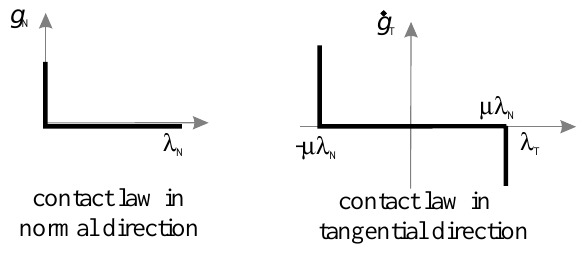
Fig. 5. Constrain